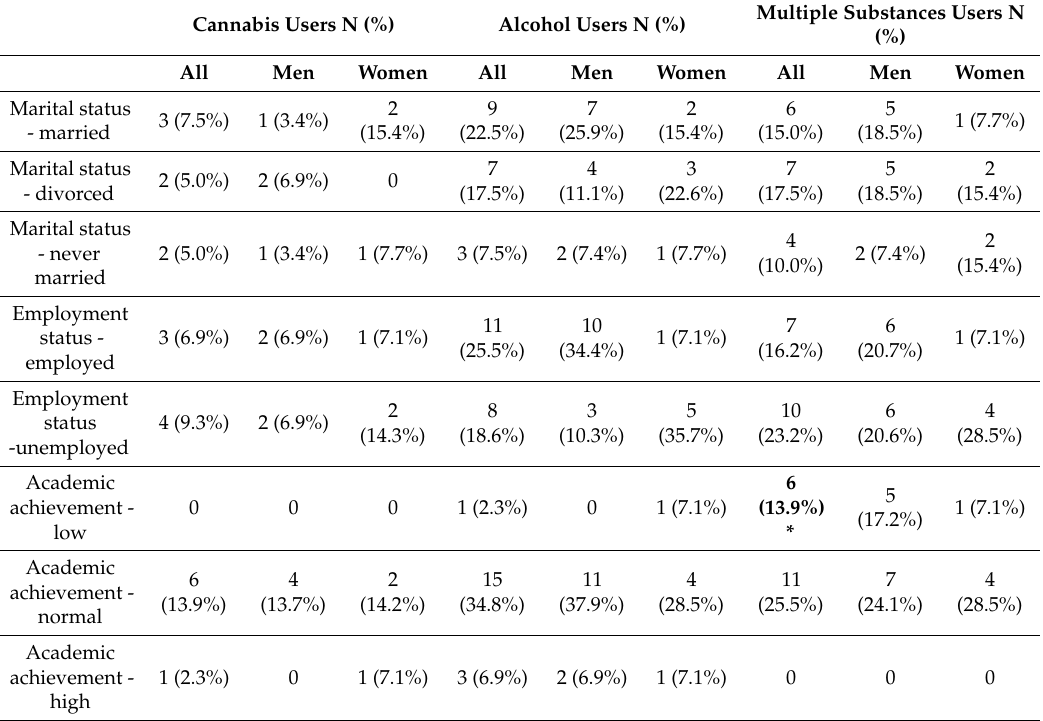
Table 1. Demographic characteristics of the sample by gender and primary substance of concern. Results are presented as number and percentage (%). Significant χ 2 -test results are marked in bold.